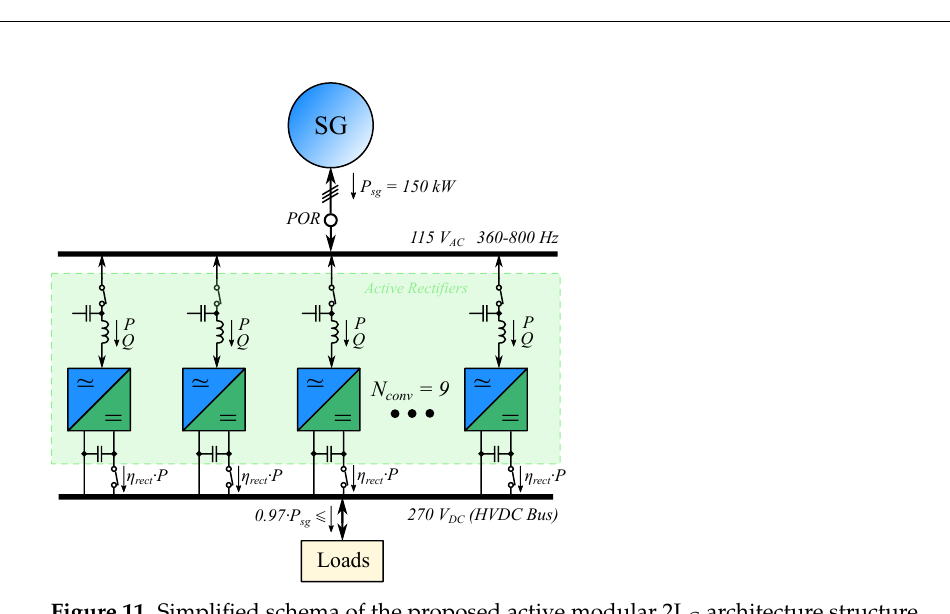
Figure 11. Simplified schema of the proposed active modular 2L C architecture structure.